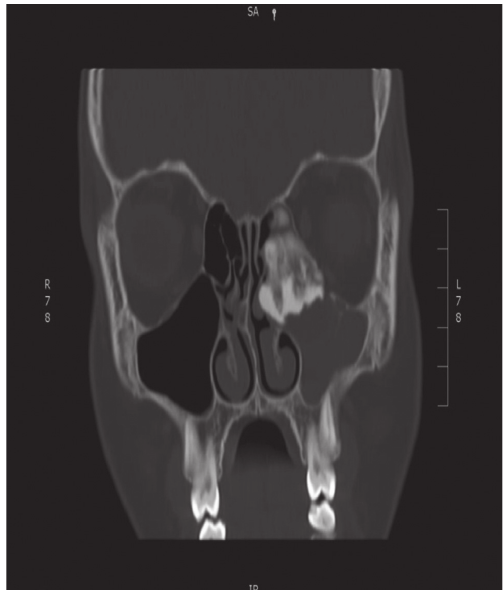
Figure 4: Computed tomography of paranasal sinuses in the coronal plane, showing a left ethmoid calcified soft tissue mass with inferior extension into the superior aspect of the left maxillary antrum.